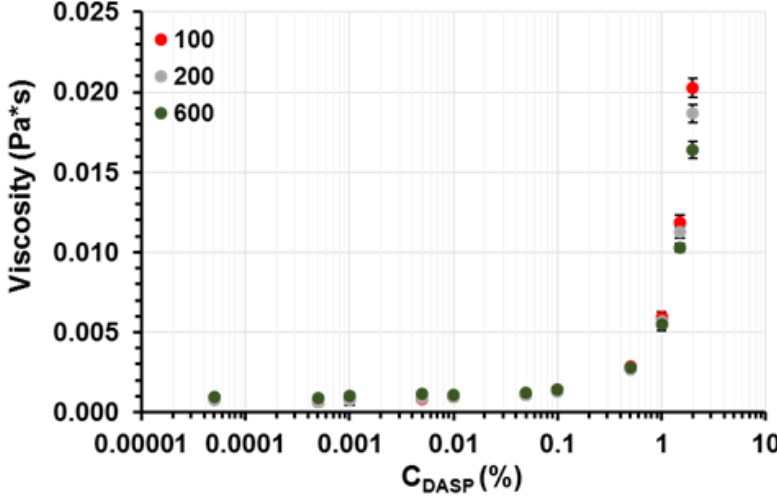
Figure 4. The dependence of viscosity on the DASP fraction concentration. Viscosity values were determined at different shear rates: γ = 100 (red circles), 200 (grey circles) and 600 s −1 (green circles). Mean values with standard deviations are given.